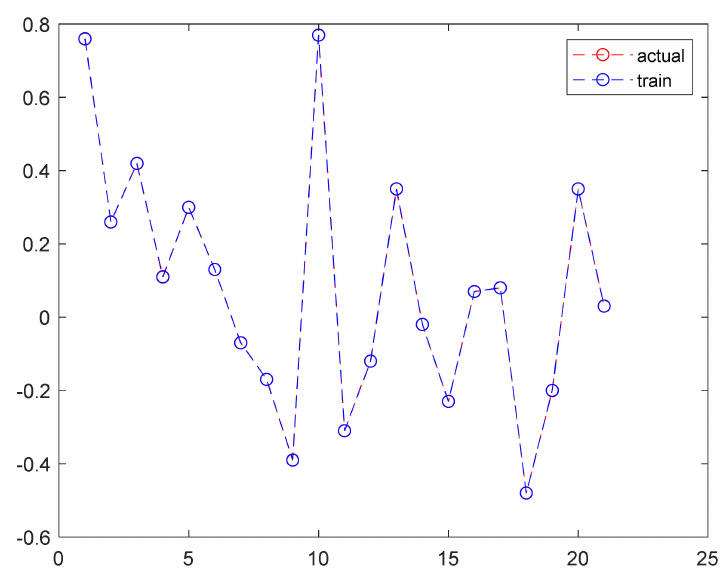
Figure 6. The training values and actual values of the N16